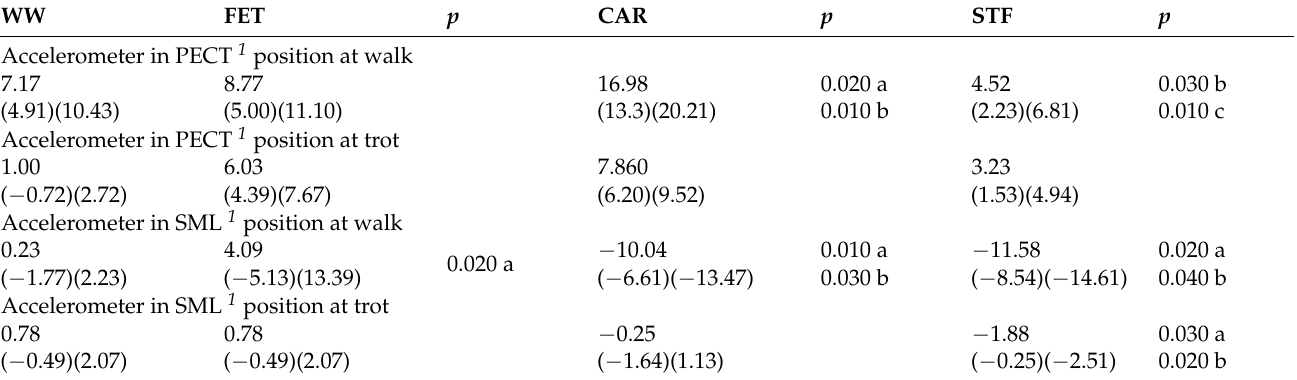
Table 1. Median and quartiles of the percent of change from baseline of the dorsoventral displacement measured on a track after WT exercise at four different water depths, at walk and at trot and with the accelerometer in two different positions. WW: treadmill without water; FET: water at the level of the fetlock; CAR: water at the level of the carpus; STF: water at the level of the stifle. 1 Position of the accelerometer: pectoral position (PECT) and sacrum midline position (SML). a: significant differences with WW; b: significant differences with FET; c: significant differences with CAR. p < 0.05.